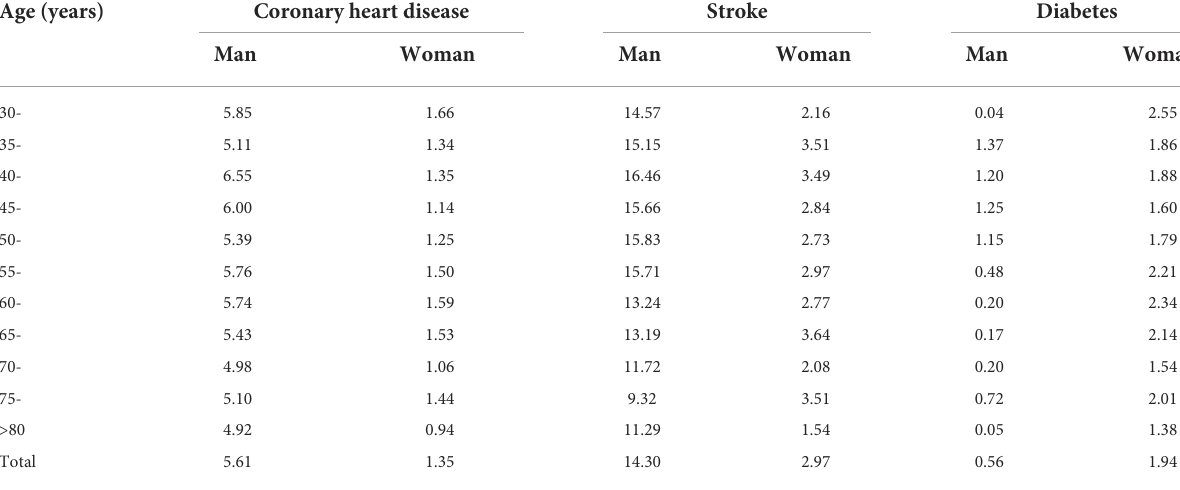
TABLE 4 Attribution scores of drinking by sex and age group in the Shanxi Province